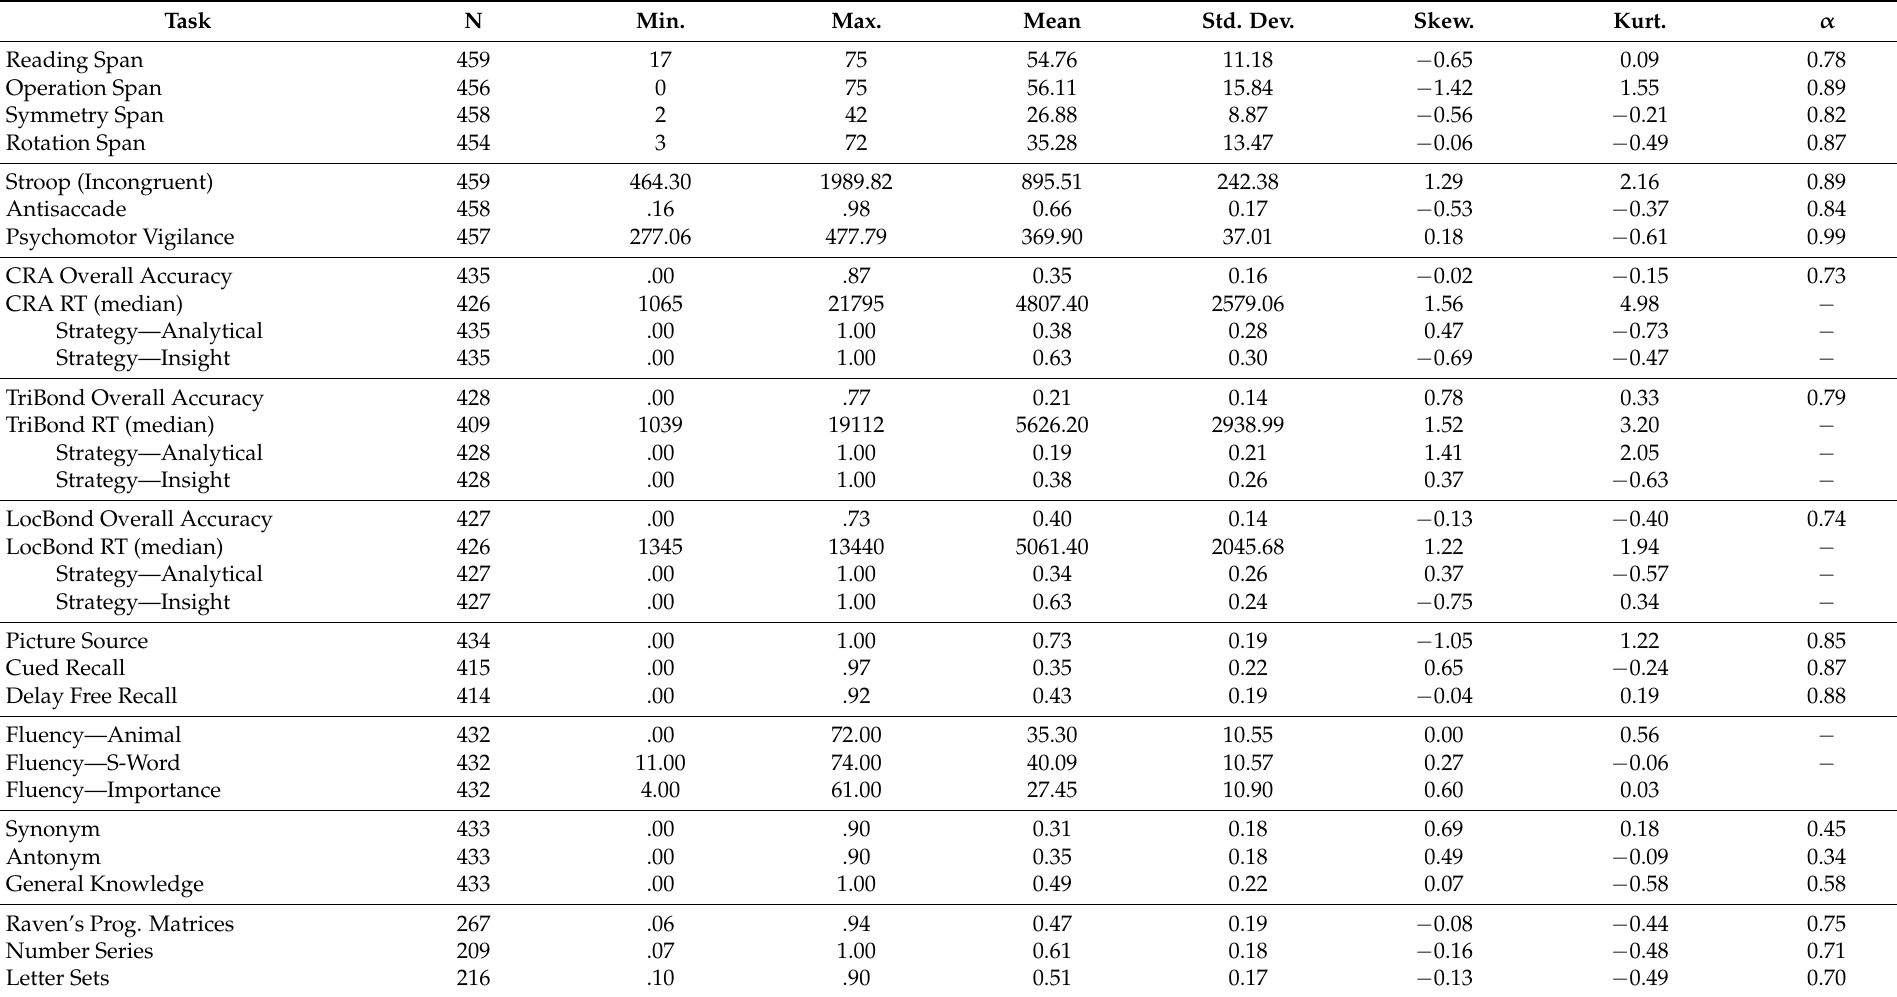
Table 1. Descriptive statistics for each dependent measure. For the compound remote associates (CRA), TriBond, and Location Bond (LocBond) data shown are for unconditionalized (overall) and conditionalized (analytical and insight) proportion correct. Response times (RT) are for correct responses